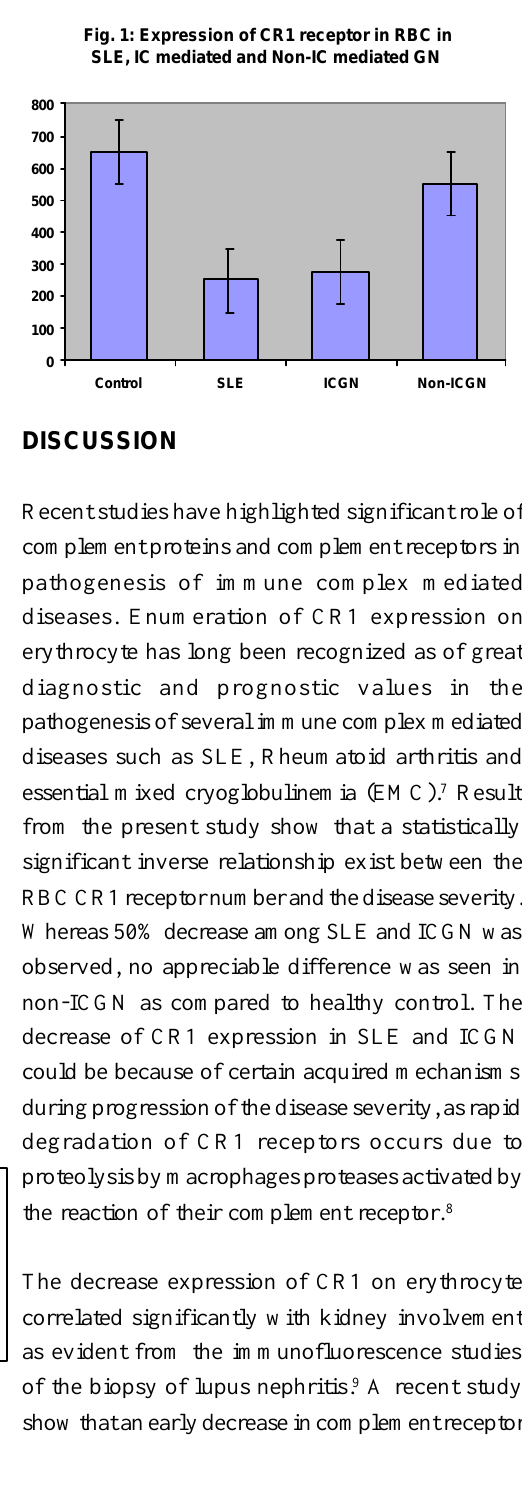
Fig. 1: Expression of CR1 receptor in RBC in SLE, IC mediated and Non-IC mediated